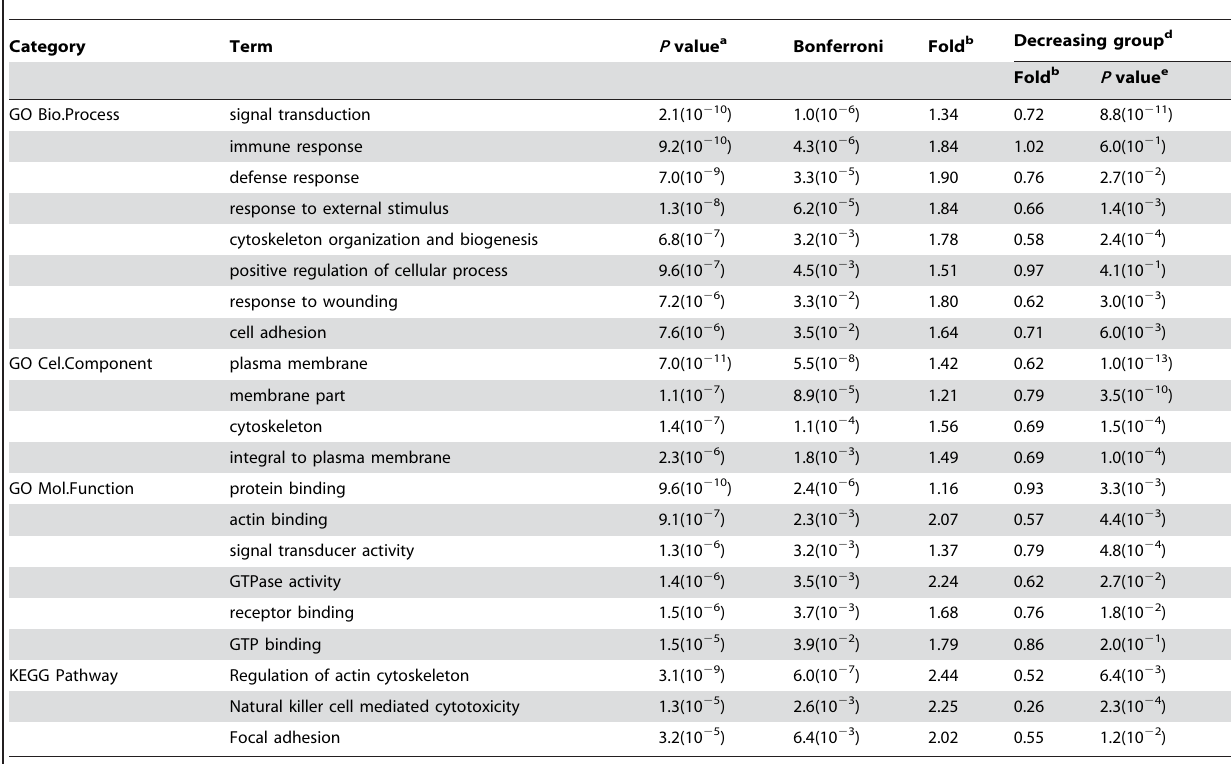
Table 8. Terms in the Gene Ontology and KEGG pathway databases over-represented among genes that increased expression with advancing age in human lymphocytes (1,430 genes in total 13,232).